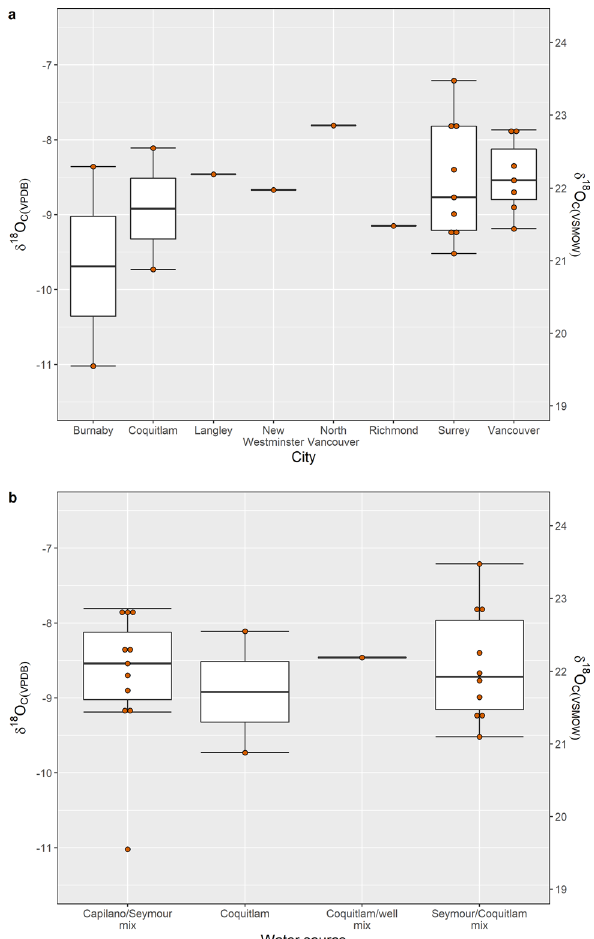
Figure 4. Boxplots of MV δ 18 O C values as represented by ( a ) city and ( b ) tap water source. The boxes represent 25th and 75th percentiles, and whiskers represent the maximum and minimum observations. When outliers are present, the whiskers extend to 1.5 times the interquartile range. The middle line denotes the median or 50 th percentile. One-way ANOVA tests showed no statistically significant inter-city differences between mean δ 18 O c values for MV [F(7, 16) = 0.717, p = 6.59], nor for mean MV δ 18 O c(VPDB) values for data disaggregated by tap water source [F(4,19) = 1.013, p =